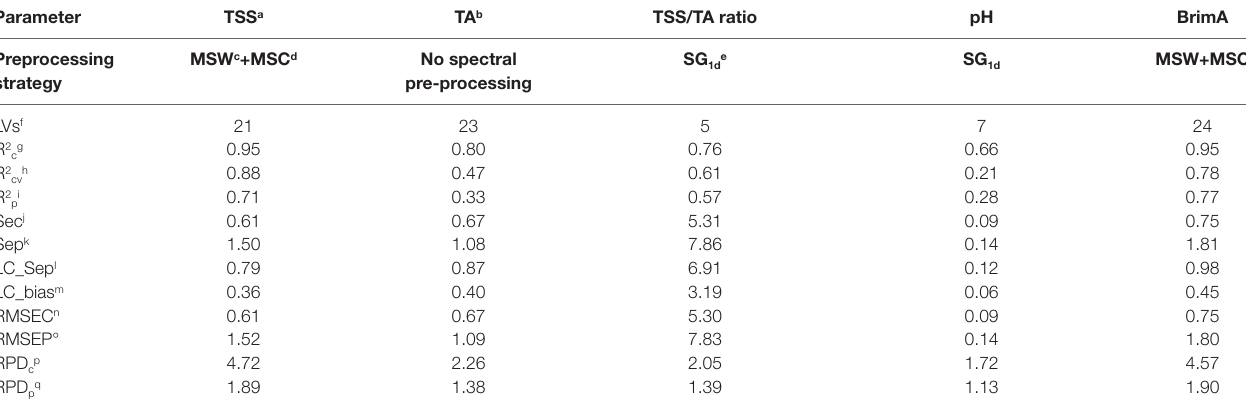
TABle 6 | Performance of Partial Least Squares (PLS) models for table grapes quality parameters of randomly selected training (n = 204) and test set (n = 134) samples of the combined 2016 and 2017 data. Also shown is the preprocessing techniques that gave the best model.